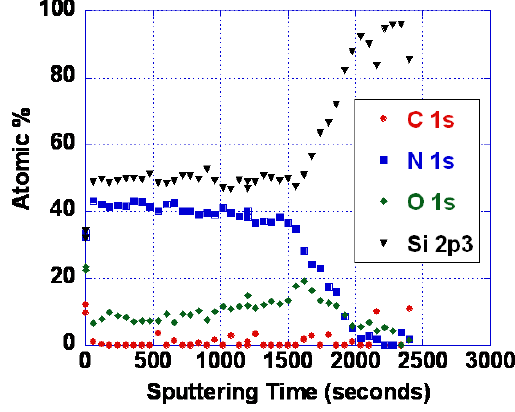
Figure 17. X-ray photoelectron spectroscopy depth profile of silicon oxynitride layer deposited on a Si substrate.